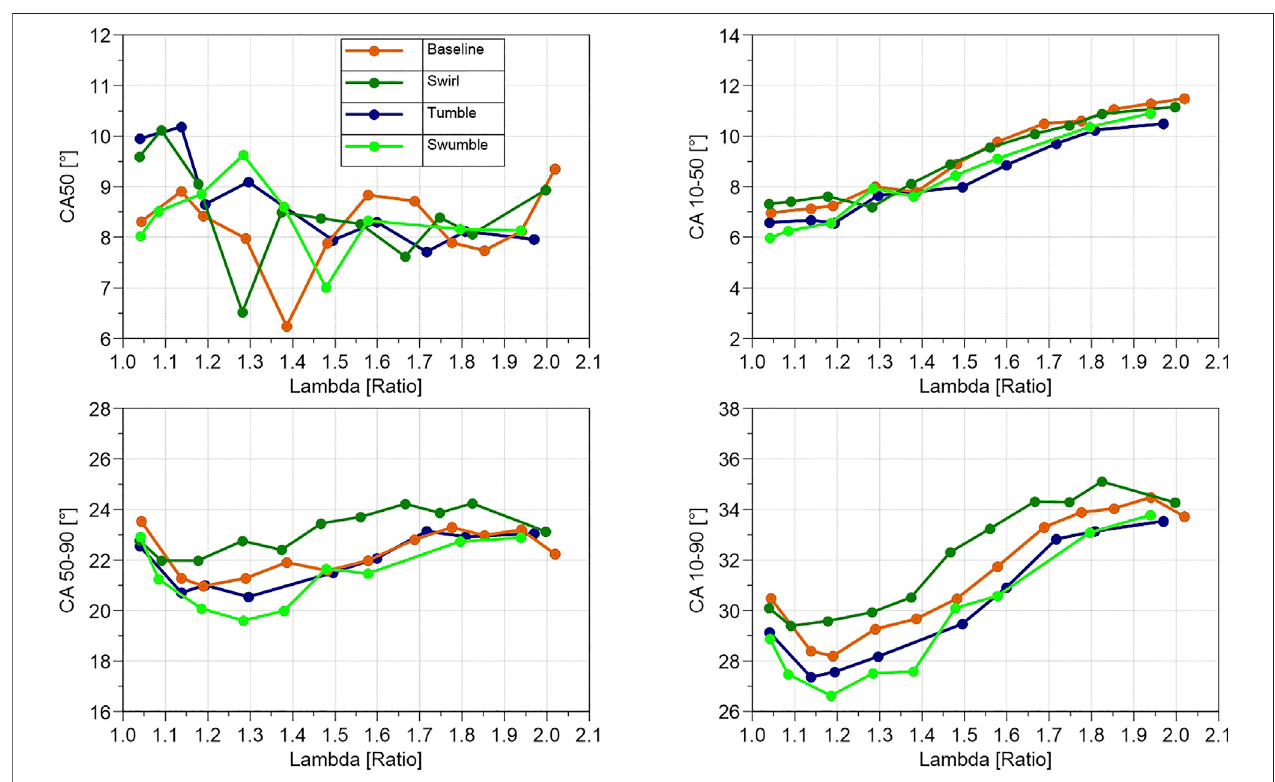
FIGURE 6 | Burn duration metrics vs. lambda; 1,500 rpm, 6 bar